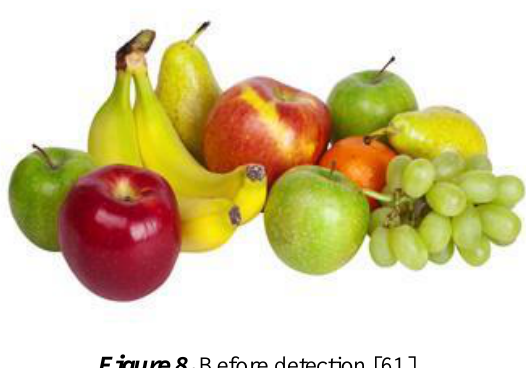
Figure 8. Before detection [61].